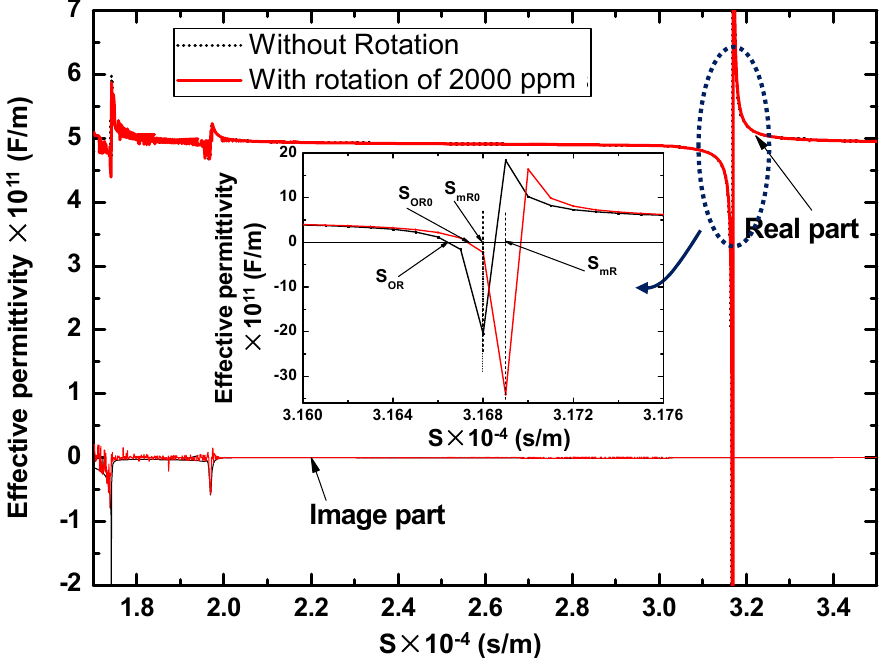
with and without rotation. 3